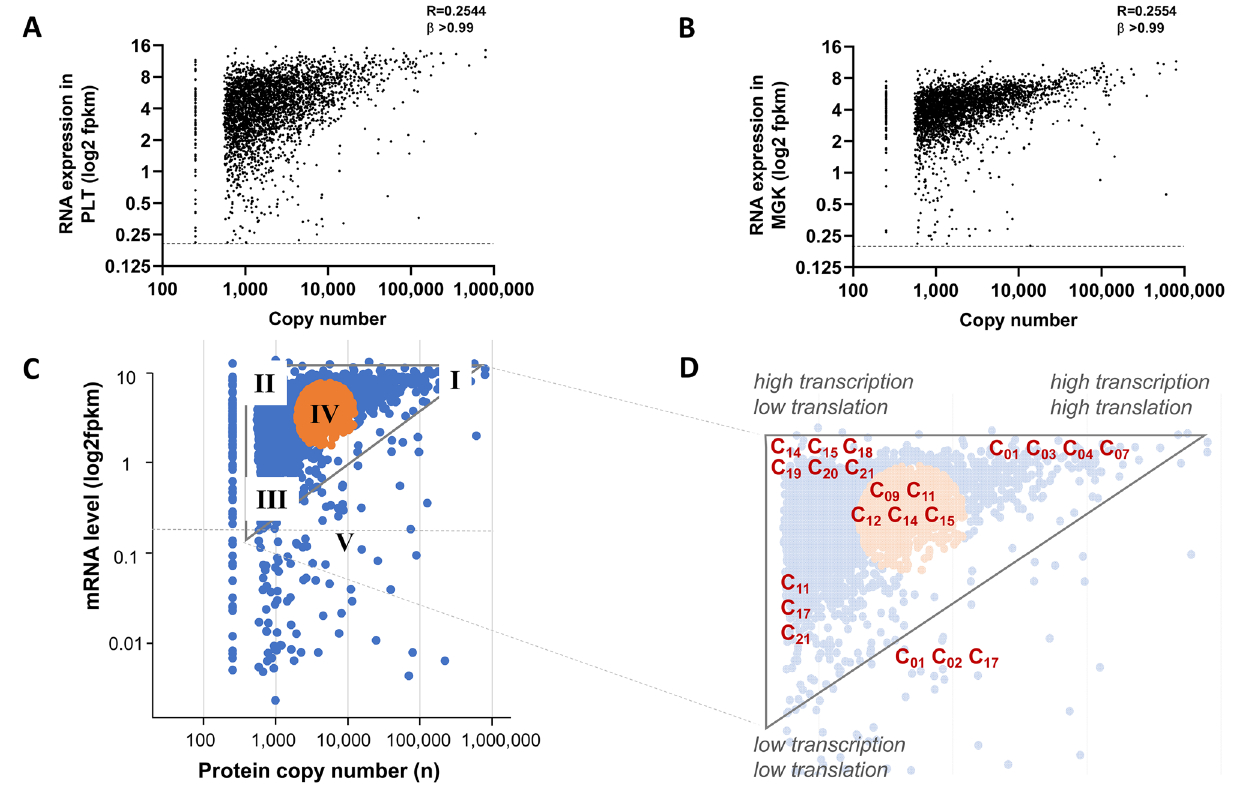
Figure 5. Comparison of protein copy numbers with mRNA levels and class-based analysis. ( A , B ) Protein copy numbers compared per gene to transcript levels (log2fpkm) for datasets of platelets (PLT, n = 3,519) ( A ) or megakaryocytes (MGK, n = 3,442). ( B ) Note triangular space, with low-abundance proteins (< 500 copies/ platelet) were normalized to 150 copies. ( C , D ) Over-representation of protein function classes in quantitative proteome-transcriptome space per predefined area (I–V). Area I is considered to represent a condition of high translation (high mRNA level) and high transcription (high copy number); area II of high translation and